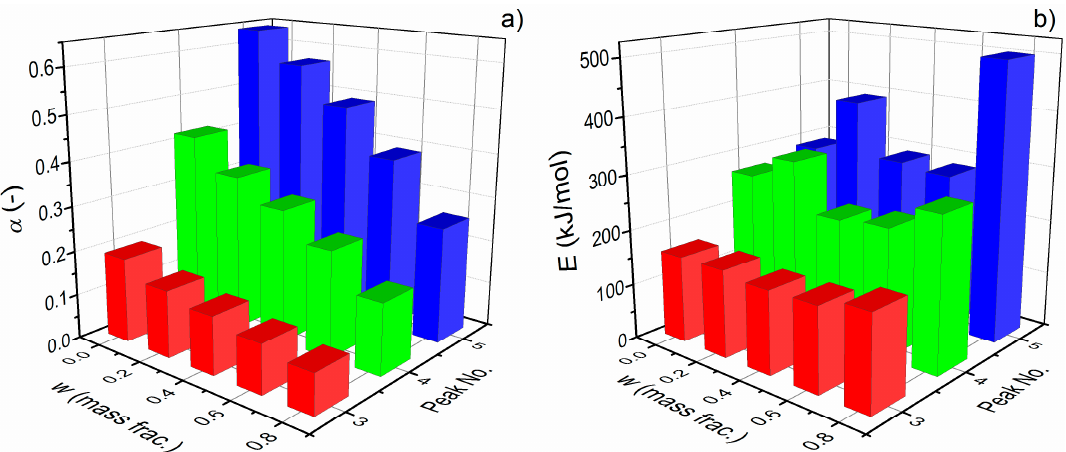
Figure 2. Changes of conversion degree ( a ) and energy activation ( b ) for peak No. 3, 4 and 5 at different ratios of mass fraction of beet pulp for an oven heating rate of 10 °C/min.